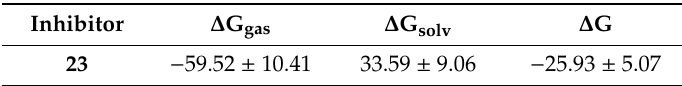
Table 5. The hydrophobic interactions residues in BChE and their corresponding occupancy rates.